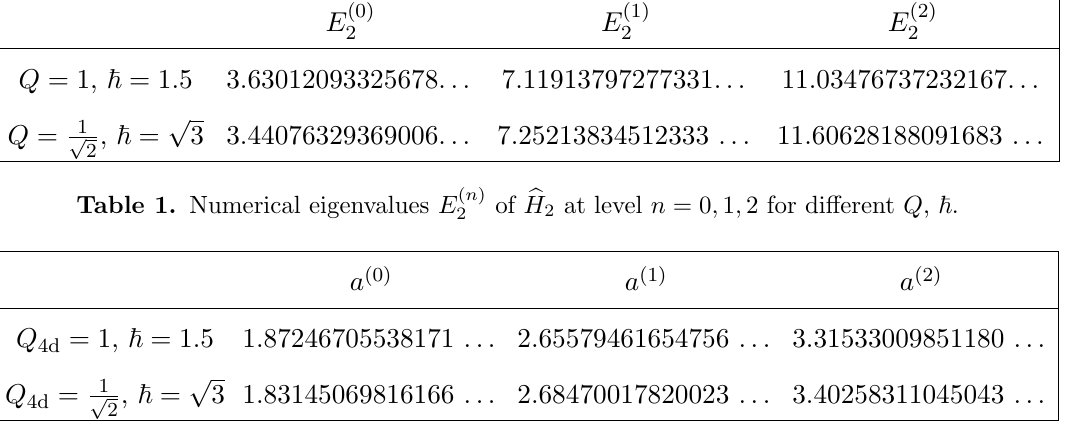
Table 2. Quantized values of a ( n ) at level n = 0 ; 1 ; 2 for di(cid:11)erent Q 4d , ~